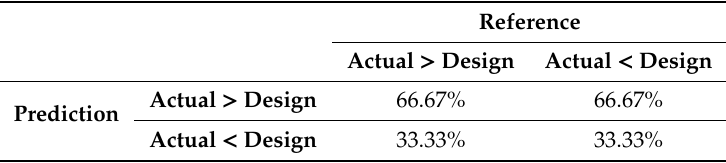
Table A3. Confusion matrix for gradient boosting machine when predicting the reliability of small